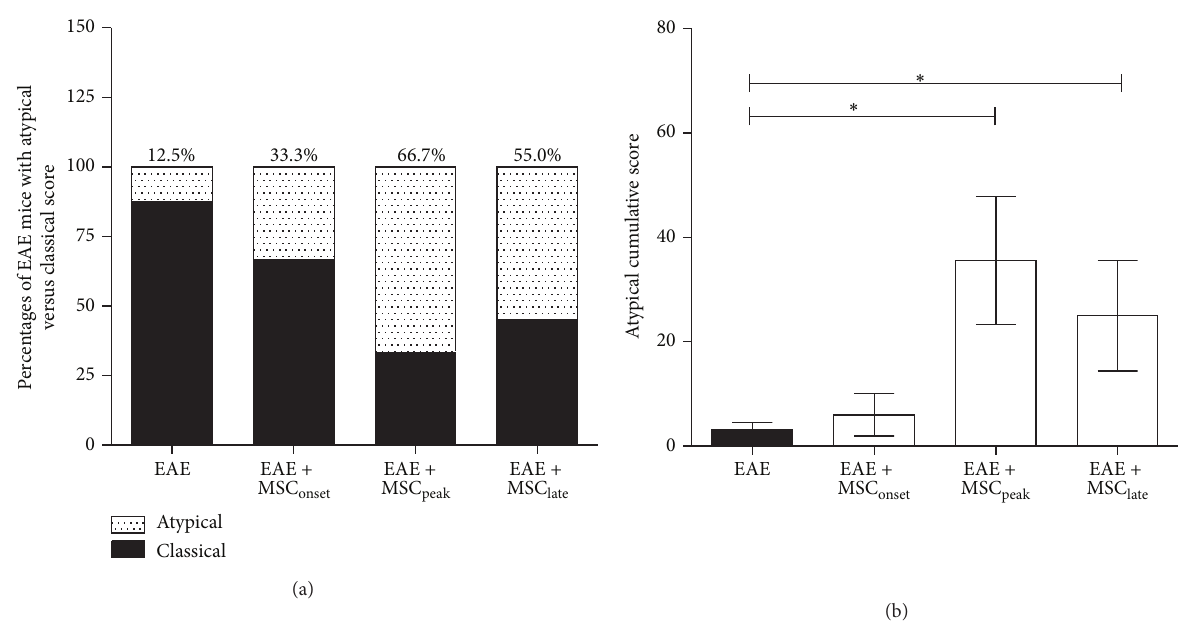
Figure 4: MSCs injections at the peak of EAE and at the time of EAE stabilization induce the appearance of atypical signs. EAE was induced on C57BL/6 mice by MOG 35−55 immunization and both classical and nonclassical atypical scores were evaluated as described in Methods. (a) Incidence of classical versus atypical EAE was calculated as the percentage of EAE mice with atypical signs over EAE mice with classical phenotype at the end of the experiment. (b) Atypical cumulative scores were calculated for untreated EAE mice (EAE) and for EAE mice ), at the peak (EAE + MSC ), and at the time of EAE stabilization (EAE + MSC ). Bars treated with MSCs at the onset (EAE + MSC onset peak late represent the mean ± SEM. Statistical differences were calculated using Mann-Whitney test ( ∗ 𝑃 < 0.05 ), 𝑛 = 7 .